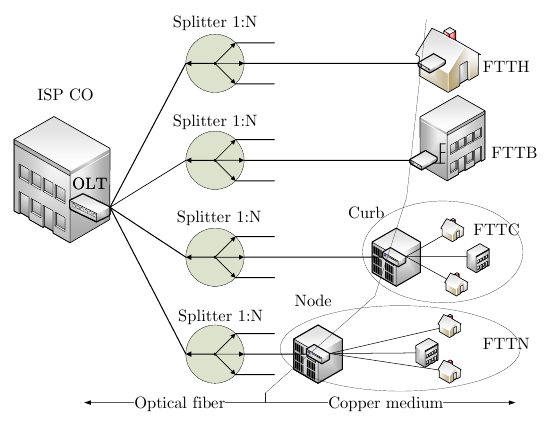
Figure 1. Passive optical networks (PON)